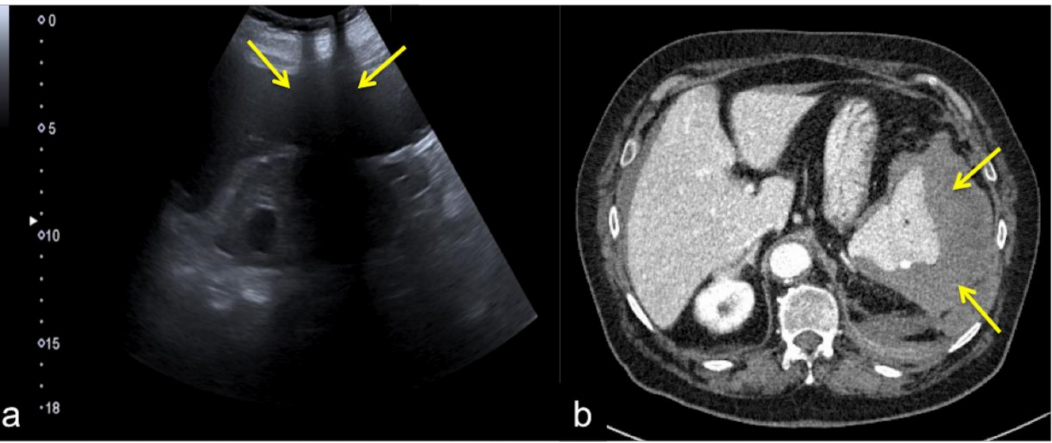
Figure 27. Coronal US scan of the left hypochondrium ( a ) is strongly influenced by the breakage of the probe crystals (arrows) and does not clearly show the large splenic hematoma. On CT scan ( b ) the splenic hematoma appears to be more evident